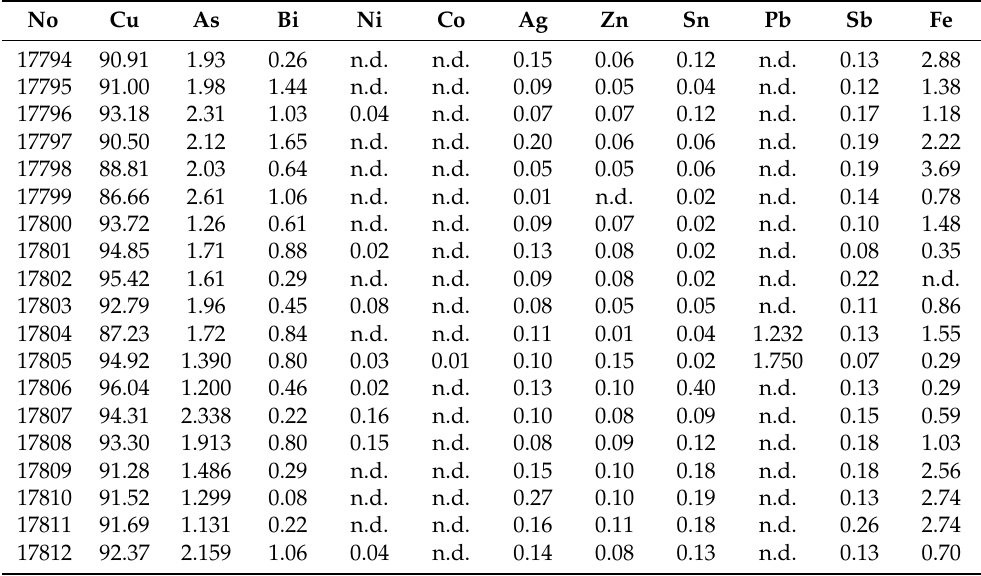
Figure 4. XRF spectrum of copper-based ( a ) Object No. 17805 dated at the Early Bronze Age; ( b ) Object 10812 dated at the Late Bronze Age. Table 1. Chemical composition (wt%) determined by XRF spectrometry of the copper-based objects Nos. 17794- 17812, Early Bronze Age (2700- 2300 BC).